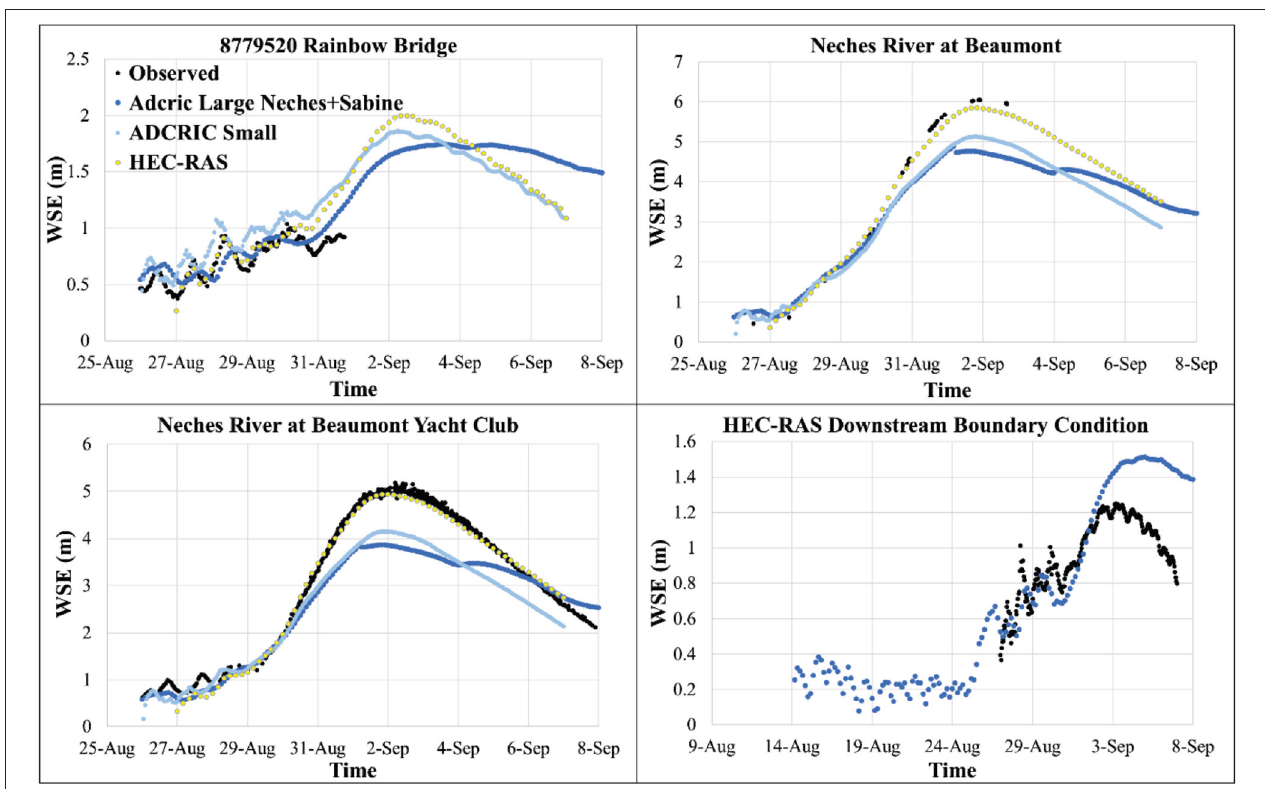
FIGURE 3 | Results of various ADCIRC simulation scenarios for water surface elevations (WSEs) at different locations (see Figure 1 for the